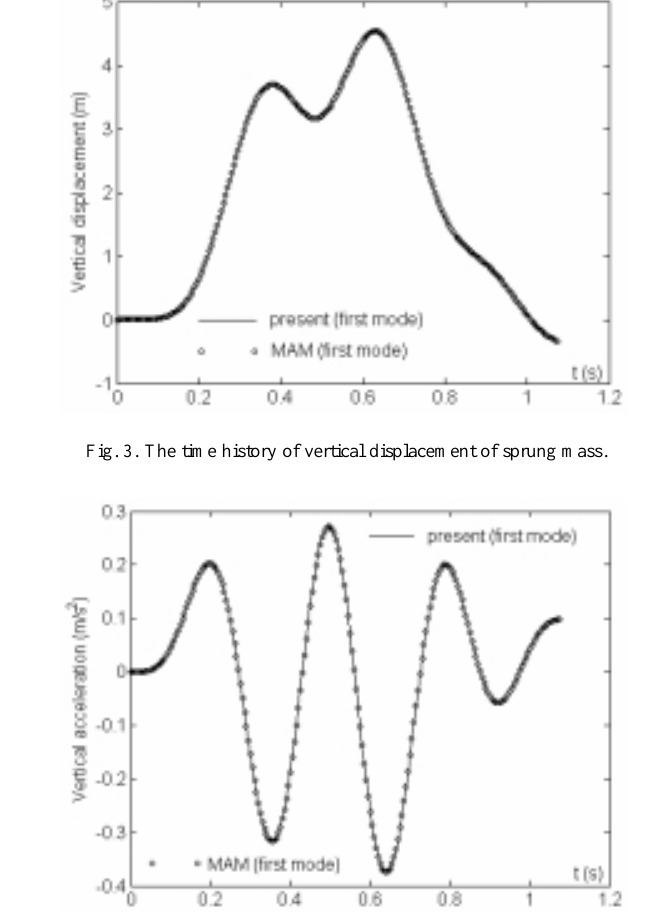
Fig. 4. The time history of vertical acceleration of sprung